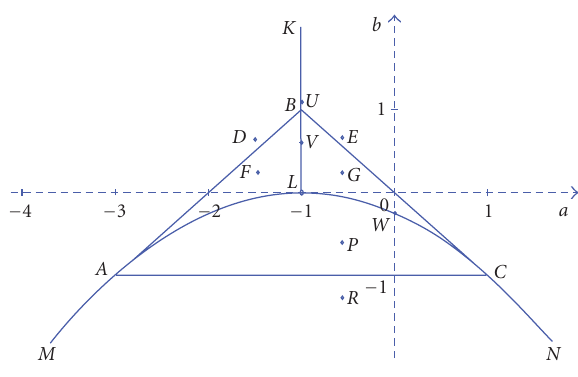
Figure 3.1. Regions with di ff erent behavior of x n and y n